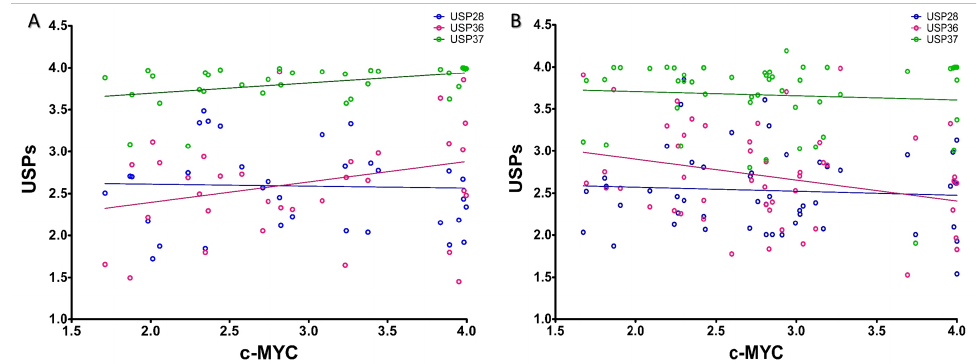
Figure 4. Correlation between c-MYC and USPs expression. Correlation between expression of c-MYC and USPs, USP28 (Blue), USP36 (Red) and USP37 (Green) are shown in the ( A ) ABC and ( B ) GCB subtypes of DLBCL. Data points are indicated with the empty circles of corresponding colors.